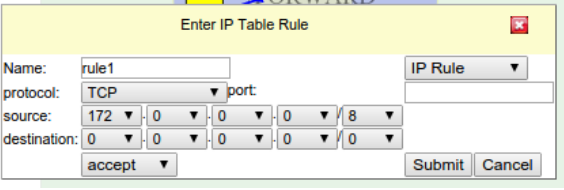
Fig. 9. An Example firewall rule, presented as a Netml form firewall specification is shown in Figure 8. An example of an IPRule is shown in Figure